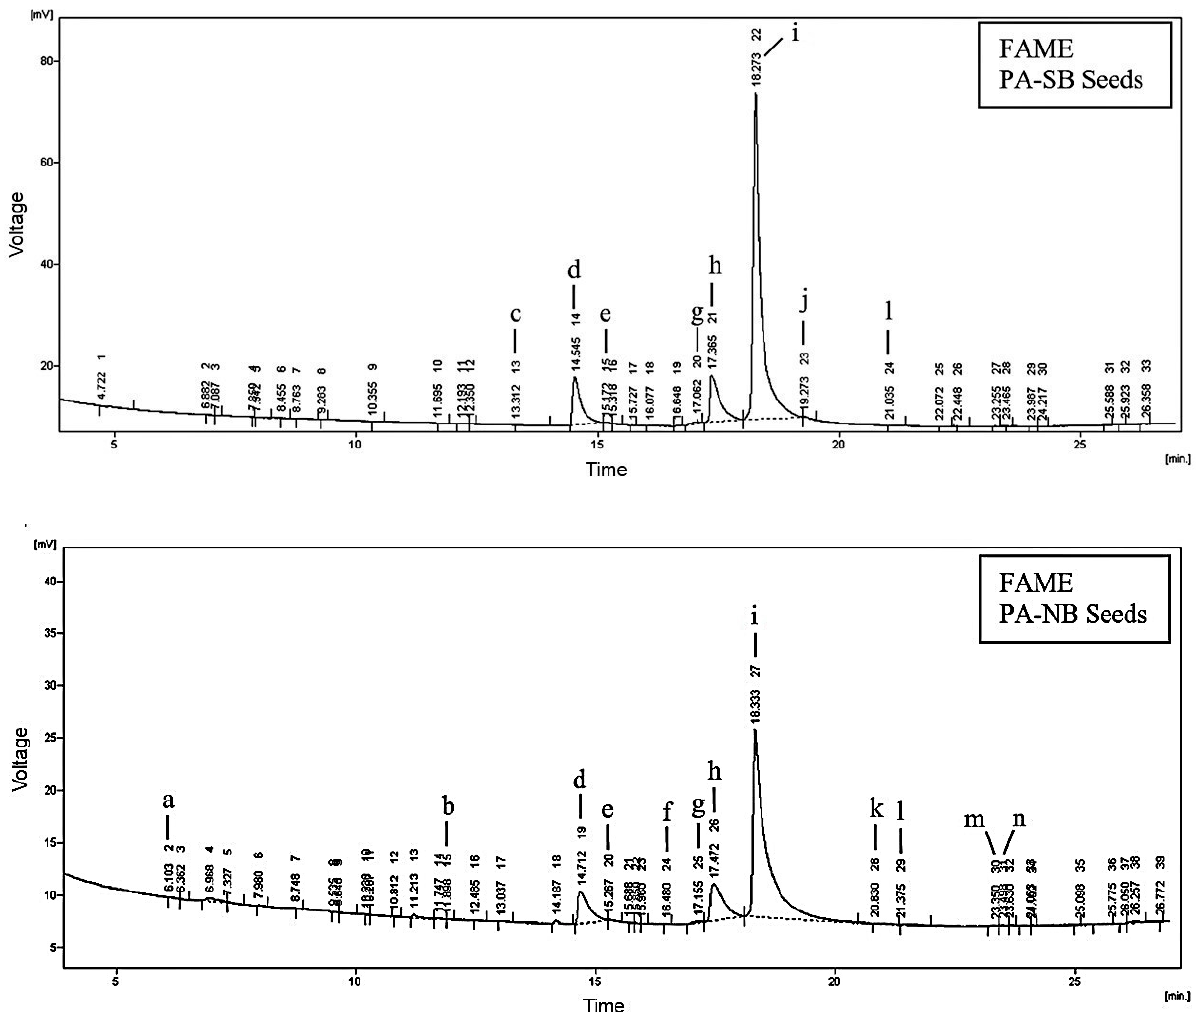
Figure 2. Chromatograms of the fatty acid composition of seed oils of two P. alkekengi phenotypes